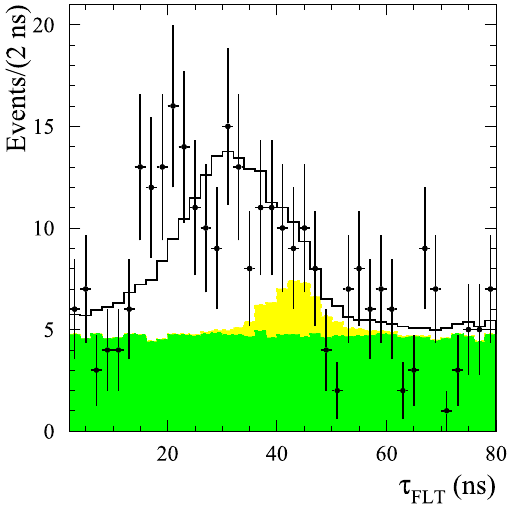
Fig. 5 The τ FLT distribution for selected data events collected in 2017 (points with error bars) at E b = 942 MeV (left panel) and at E b = 1003 MeV (right panel). The solid histogram is the result of the